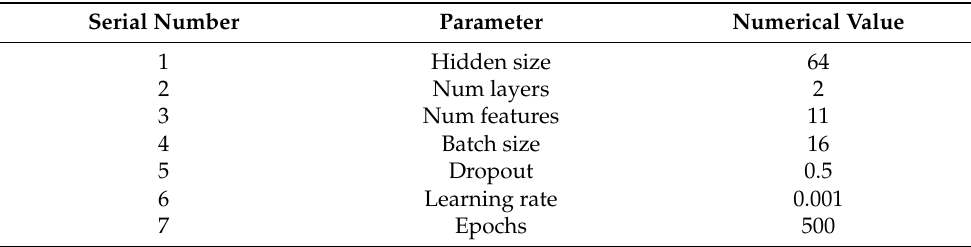
Table 3. Parameters of encoder model.